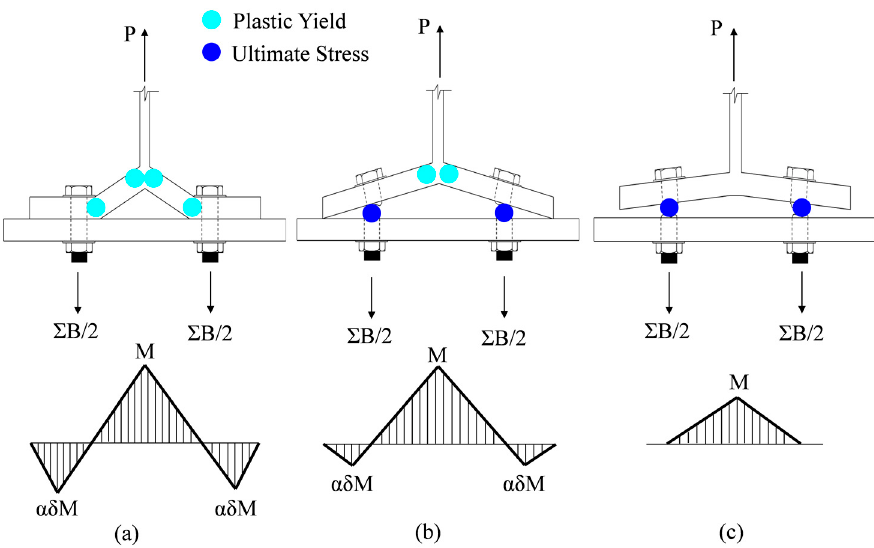
Figure 4. Three possible failure modes: ( a ) Mode 1 ( α > 1); ( b ) Mode 2 (0 < α ≤ 1); ( c ) Mode 3 ( α ≤ 0).